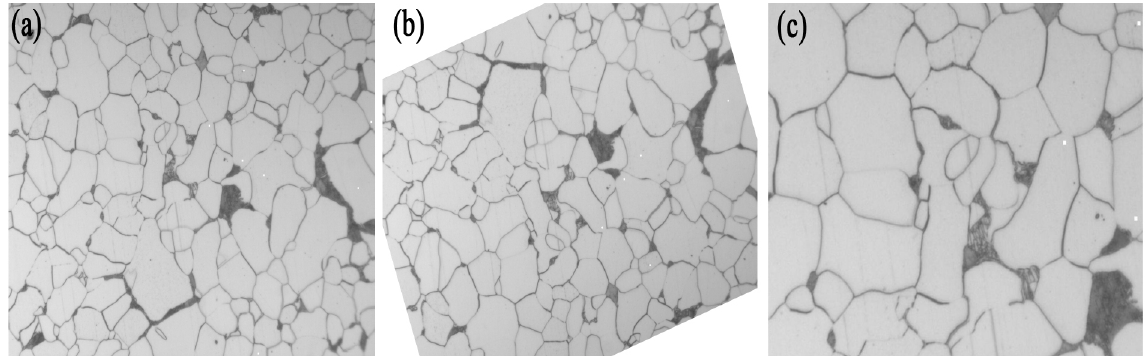
Figure 4. Random rotation and scaling images (Original ( a ), Rotated ( b ), Enlarged ( c )). Random erasing is a new data measurement technique, which erases the pixels with random values in the randomly selected rectangular areas in training, so as to obtain more occlusions or erase pixel values and images with different areas for data enhancement. This technique can reduce the risk of fitting and make the model robust to occlusion and erasure. The results are shown in Figure 5.